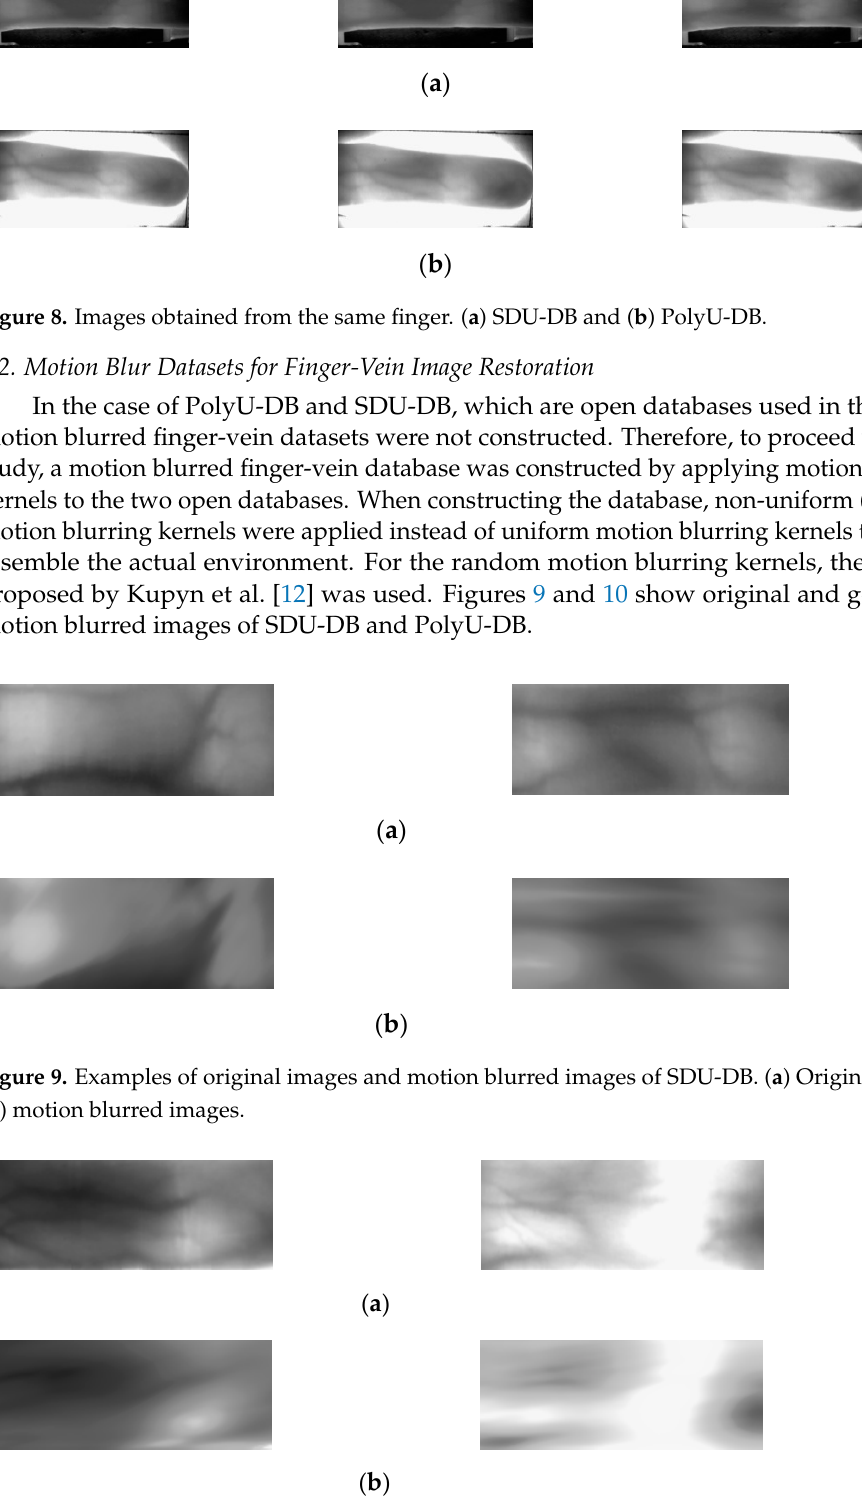
Figure 8. Images obtained from the same finger. ( a ) SDU-DB and ( b ) PolyU-DB.